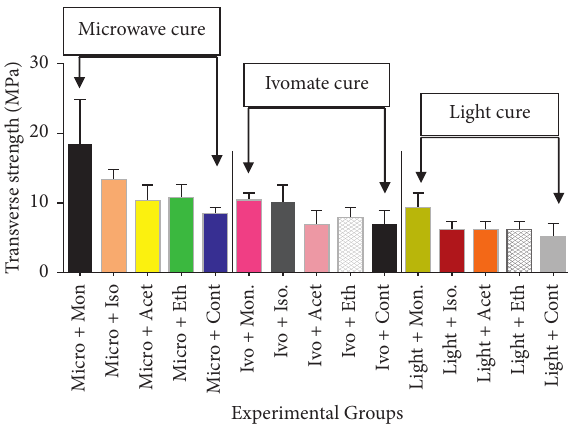
Figure 2: Mean and standard deviations of transverse strength values of experimental and control